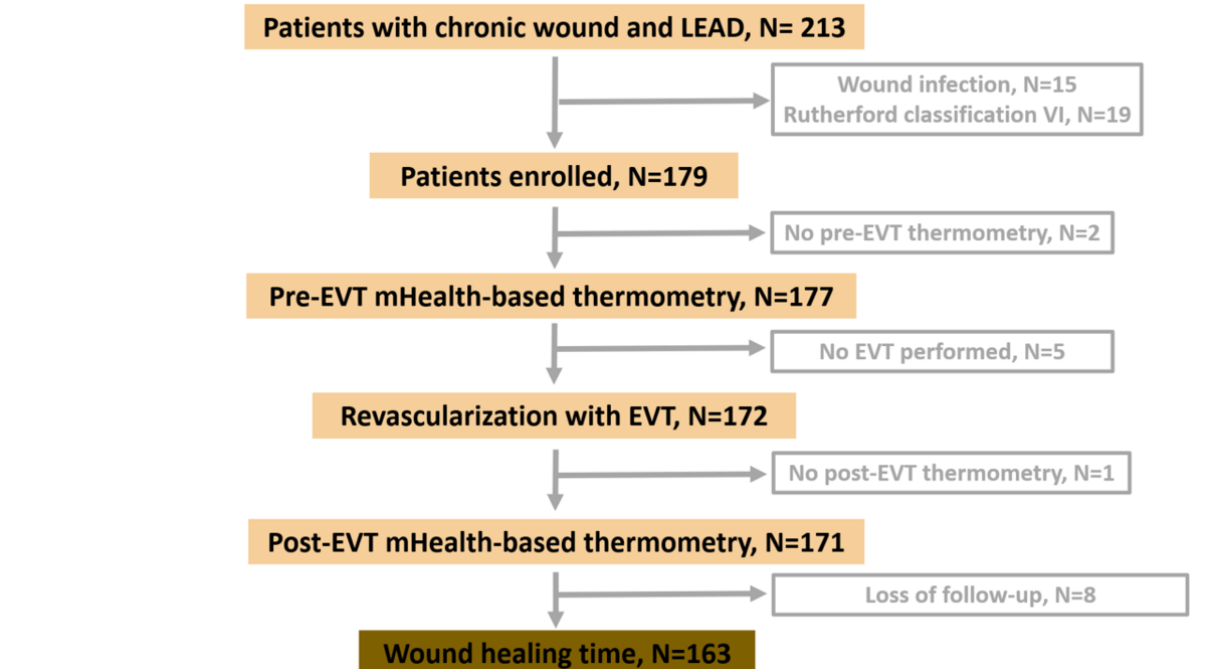
Figure 2. Participant flowchart. LEAD: lower extremity arterial disease; EVT: endovascular